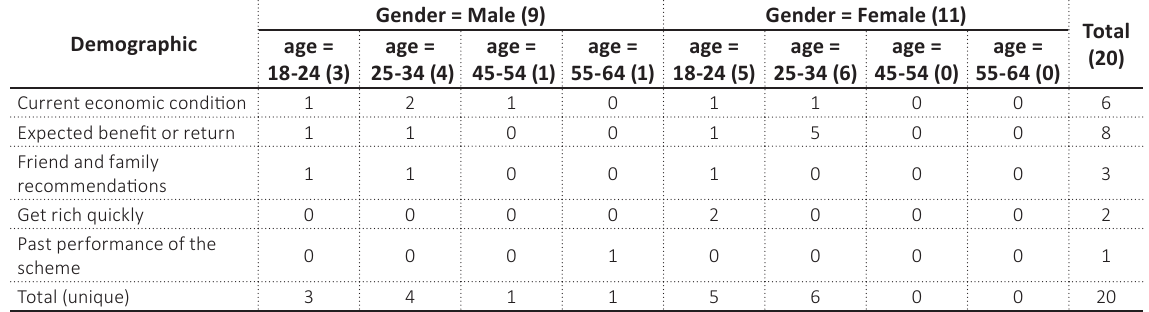
Table 3. Comparison between gender and age group and factors leading to the uptake of pyramid schemes Demographic